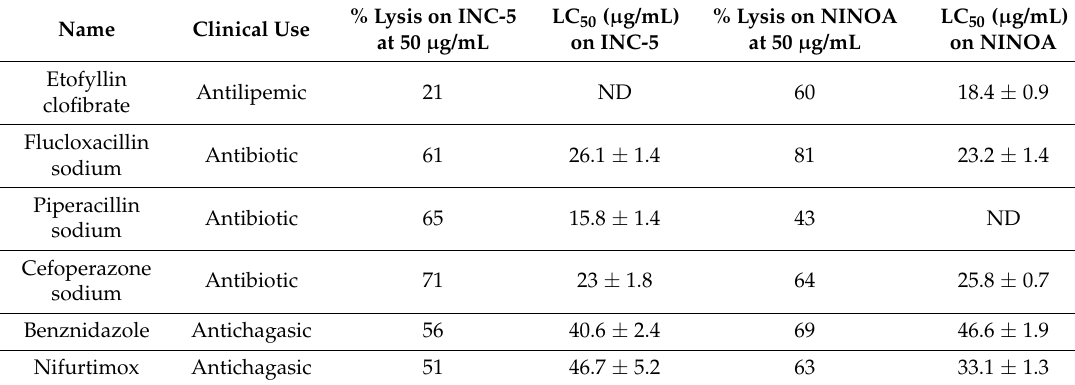
Table 2. LC 50 of the FDA drugs on T. cruzi